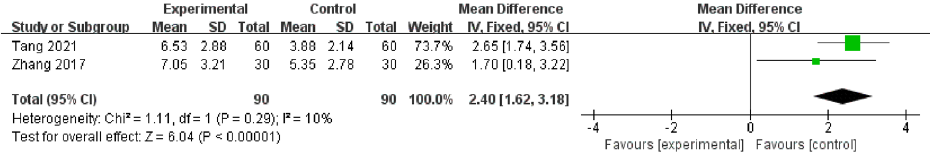
Figure 8. Artificial tears vs. Artificial tears plus Auricular acupressure on SIT [51,52].